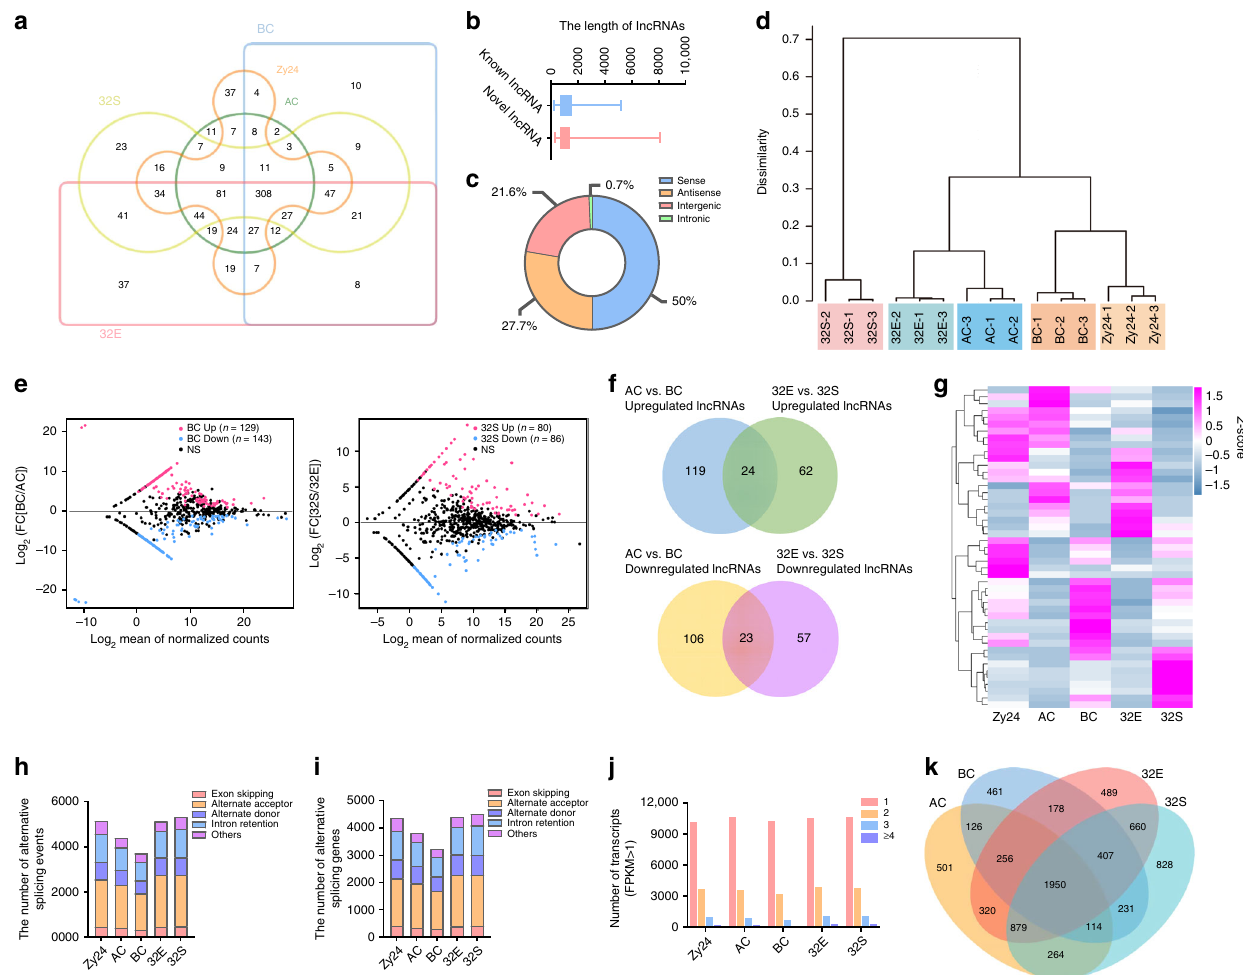
Fig. 6 The expression of lncRNAs and alternative splicing isoforms during the process of apical and basal cell lineage speci fi cation. a Venn diagram of the lncRNAs in fi ve different cell types. b The length of known and novel lncRNAs identi fi ed in early embryos. Whiskers in box plots indicate the minimum and maximum length of lncRNAs. c Proportions of different types of lncRNAs identi fi ed in early embryos. d Hierarchical clustering of zygote, apical, and basal cell lineages of early proembryos based on the expression of lncRNAs. e MA plots depict differentially expressed lncRNAs between apical and basal cell, or between 32E and 32S. f Overlap analysis of upregulated or downregulated lncRNAs between AC/BC and 32E/32S. g Heatmap showing the expression of apical cell lineage- and basal cell lineage-maintained lncRNAs in early embryogenesis. h , i The number of alternative splicing events ( h ) and genes ( i ) in different cells. j The number of genes with different transcripts in each cell type. k Overlap analysis of alternative splicing transcripts identi fi ed in apical and basal